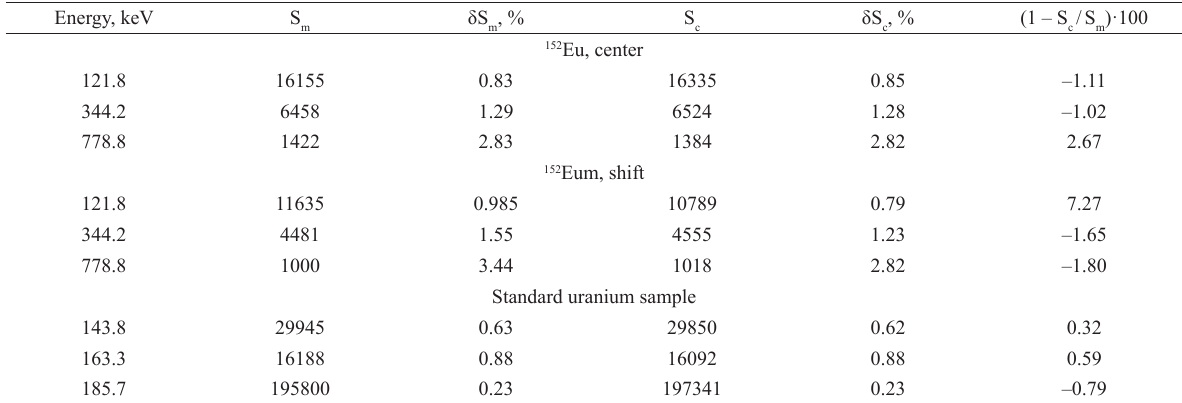
Table 1. Peak areas obtained as the result of the calculations and the experiment Energy, keV